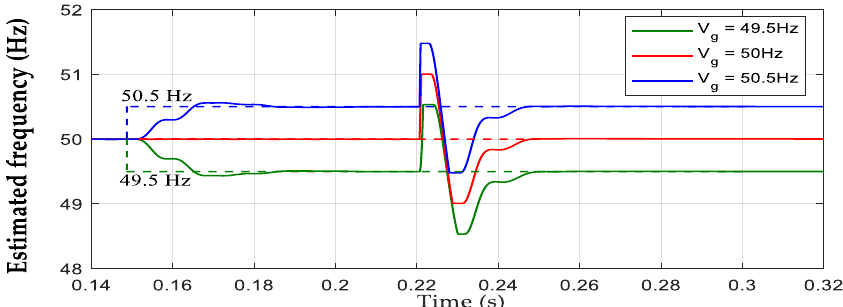
Figure 14. Estimated frequency transient responses to 80% depth voltage sags produced at different grid frequency values. In blue: ω g = 50.5 Hz. In red: ω g = 50 Hz. In green: ω g = 49.5 Hz.